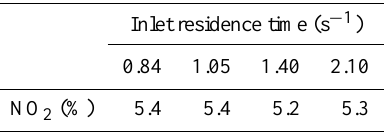
Figure 1. The average raw counts per second (left) and pptv (right) recorded by a LIF instrument when sampling various mixing ratios of PAN (in red) and zero air (black). The variance of the zero-air signal is also shown (dashed black). The average signal while sam- pling PAN falls within the noise of the zero signal. Table 2. Effect of varying the residence time of PAN (1.0ppb) within a 2.7m PFA inlet on artifact NO 2 in switching mode.